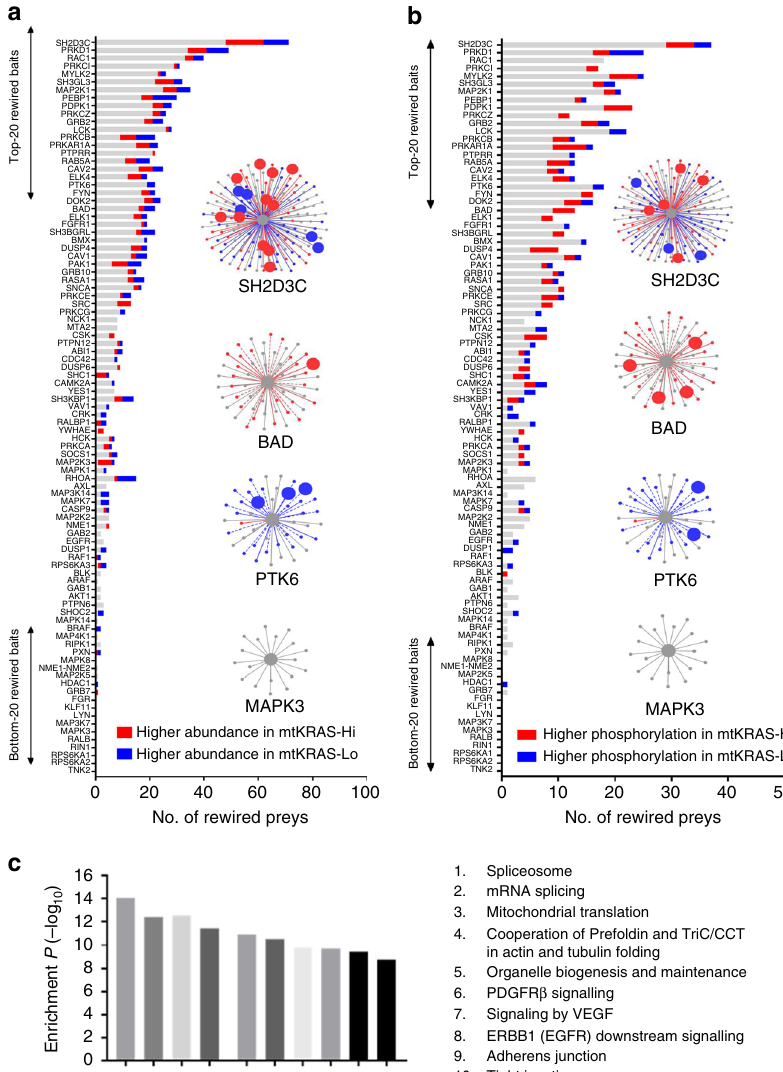
Fig. 3 Potential drivers of the EGFR PPI network rewiring. a The number of rewired prey proteins for each bait-prey AP-MS complex that were assessed for differential protein expression between the two cell lines. Rewired prey proteins that were signi fi cantly more abundant in the mtKRAS Hi cells are shown in red. Rewired prey proteins that were signi fi cantly more abundant in the mtKRAS Lo cells are shown in blue. Four selected AP-MS complexes highlighting differentially abundant prey proteins (larger nodes) are also shown. b The number of rewired prey proteins for each bait-prey AP-MS complex that were assessed for differential phosphorylation between the two cell lines. Rewired prey proteins that were signi fi cantly more phosphorylated in the mtKRAS Hi cells are shown in red. Rewired prey proteins that were signi fi cantly more phosphorylated in the mtKRAS Lo cells are shown in blue. Four selected AP-MS complexes highlighting differentially phosphorylated prey proteins (larger nodes) are also shown. c Statistically enriched pathways among the 735 prey proteins involved in rewired interactions. Source data are provided as a Source Data fi